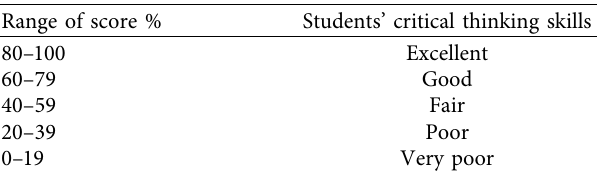
Table 4: Score range for rating mathematical critical thinking skills